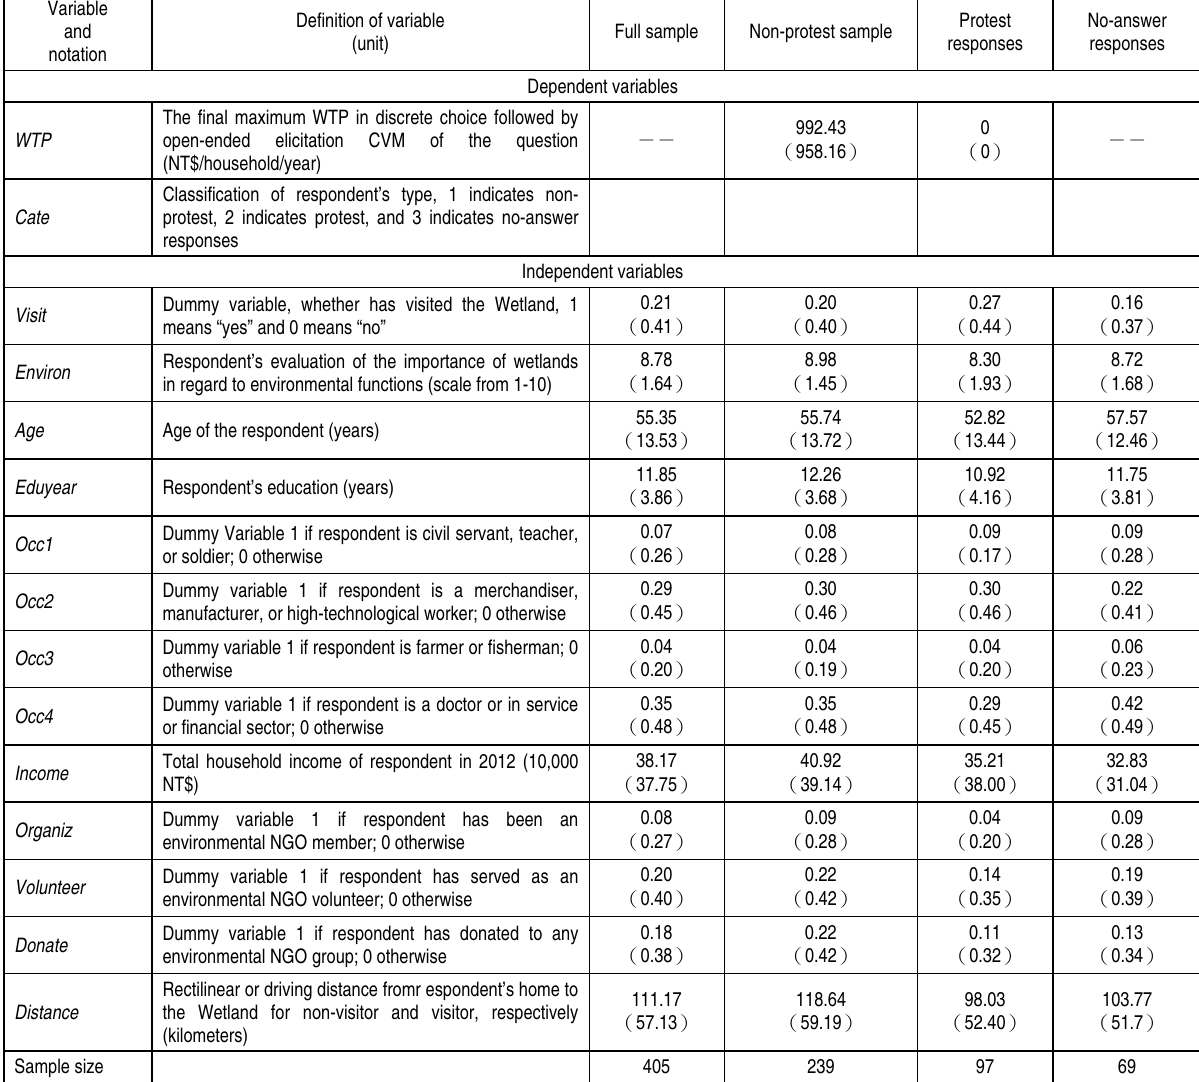
Table 1. Definition and mean values for all variables used in different estimations